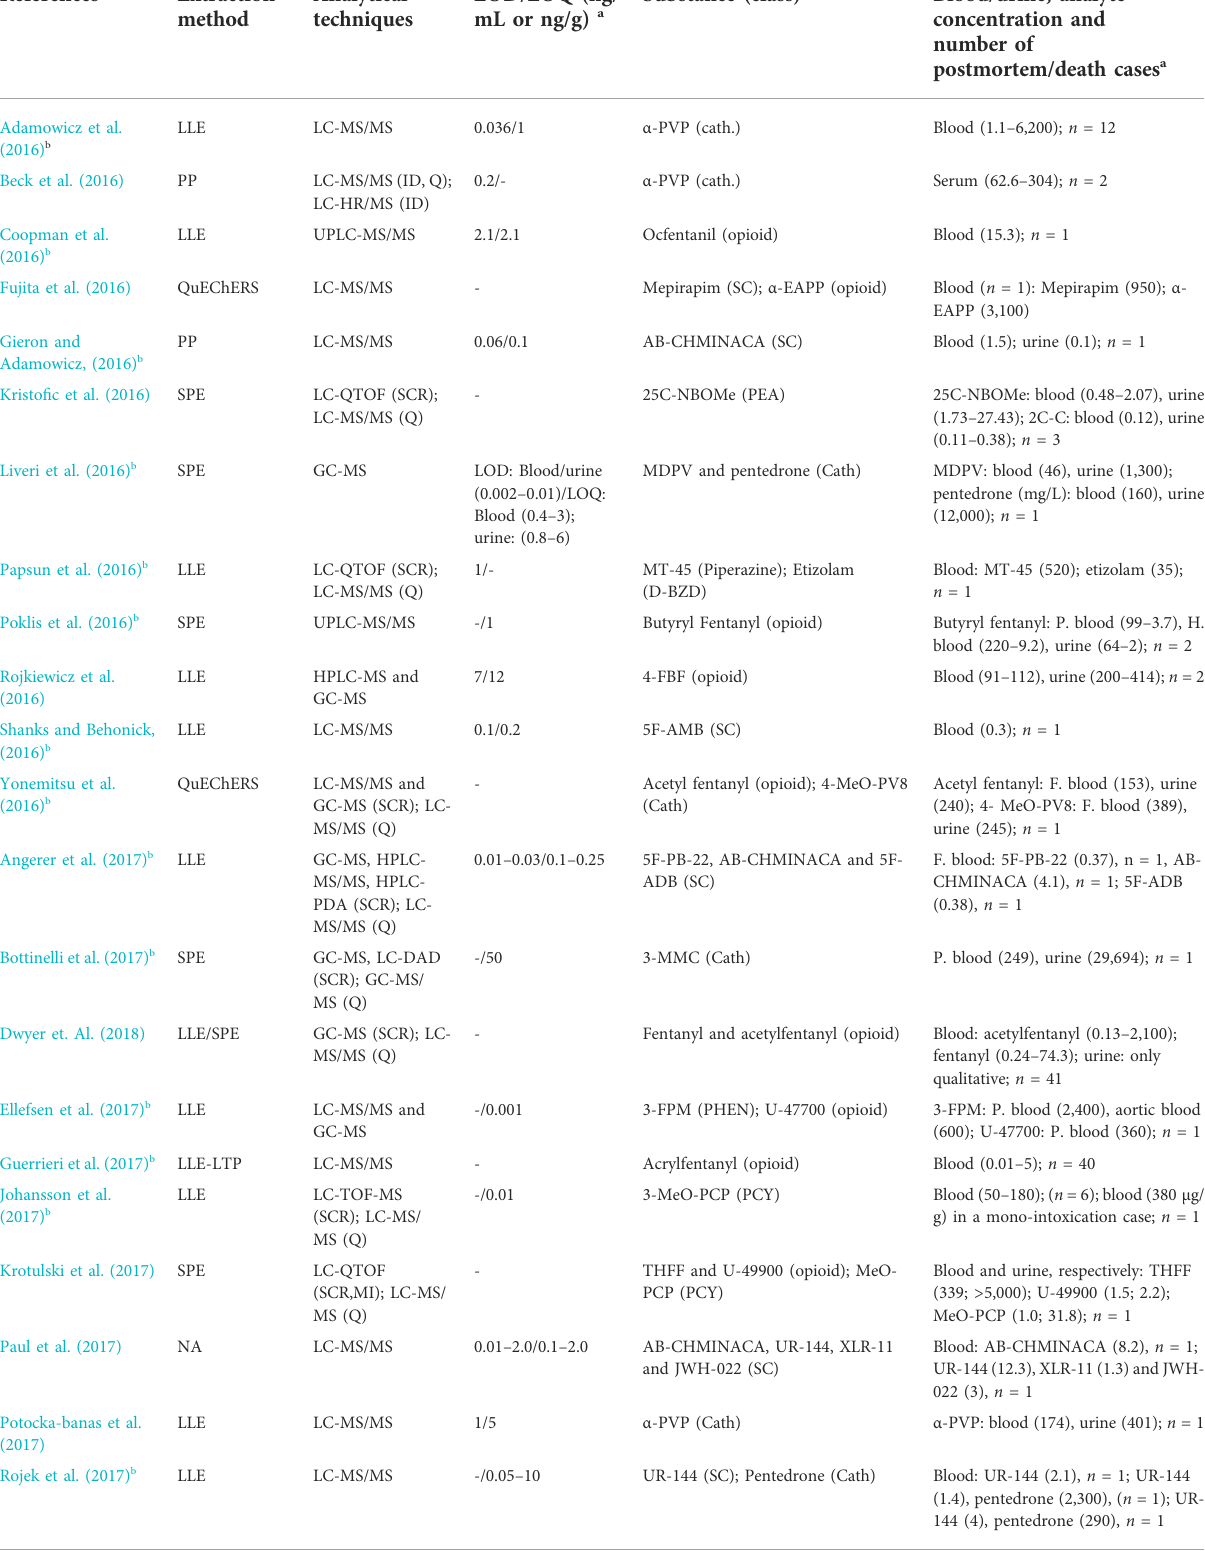
TABLE1Summaryofresults foundinthe 96papersincludedin thisreview thatinvestigated newpsychoactive substances inbloodand/orurinefrom fatal cases. Aditional information of each study can be found in Supplementary Table